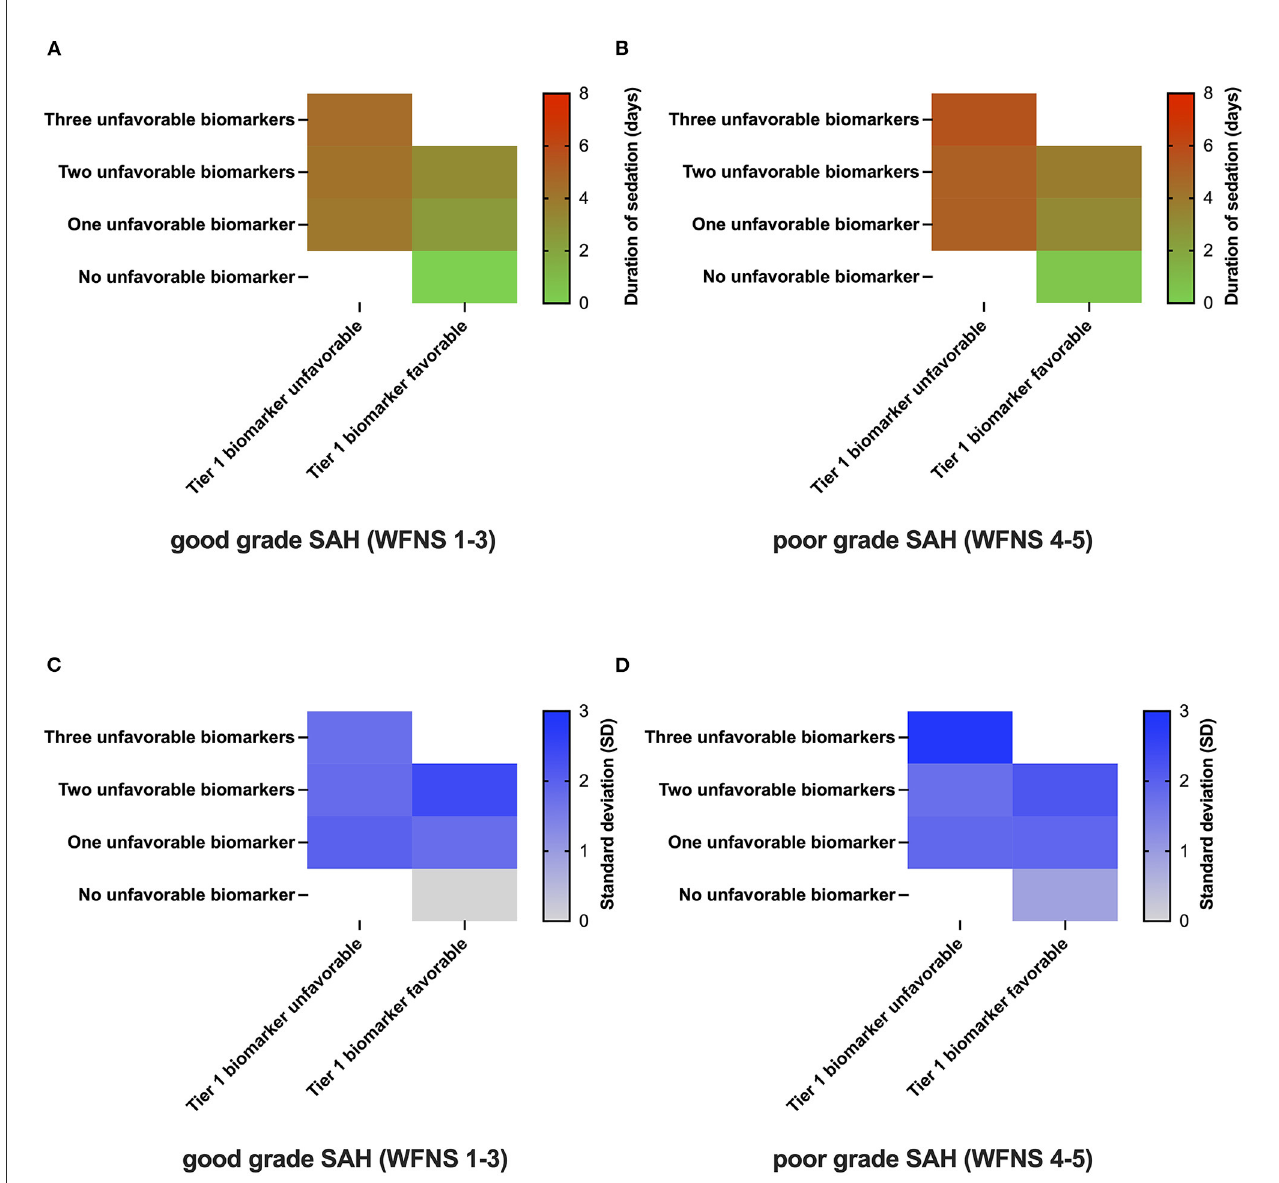
FIGURE4 Duration of sedation as a function of SAH biomarkers. The number of unfavorable biomarkers is represented on the y-axis, whereas the most important biomarker’s value for the respective answering physician is coded on the x-axis [ (A, B) ; n = 7]. Duration of sedation in patients with SAH as a function of the presence/absence of biomarkers in good-grade SAH (WFNS 1-3, Panel A ) and poor-grade SAH (WFNS 4-5, Panel B ). The one-gradient heatmap codes for the time of prolonged sedation in days [ (C, D) ; n = 7]. The standard deviation of responses for the various clinical scenarios coded by a one-gradient